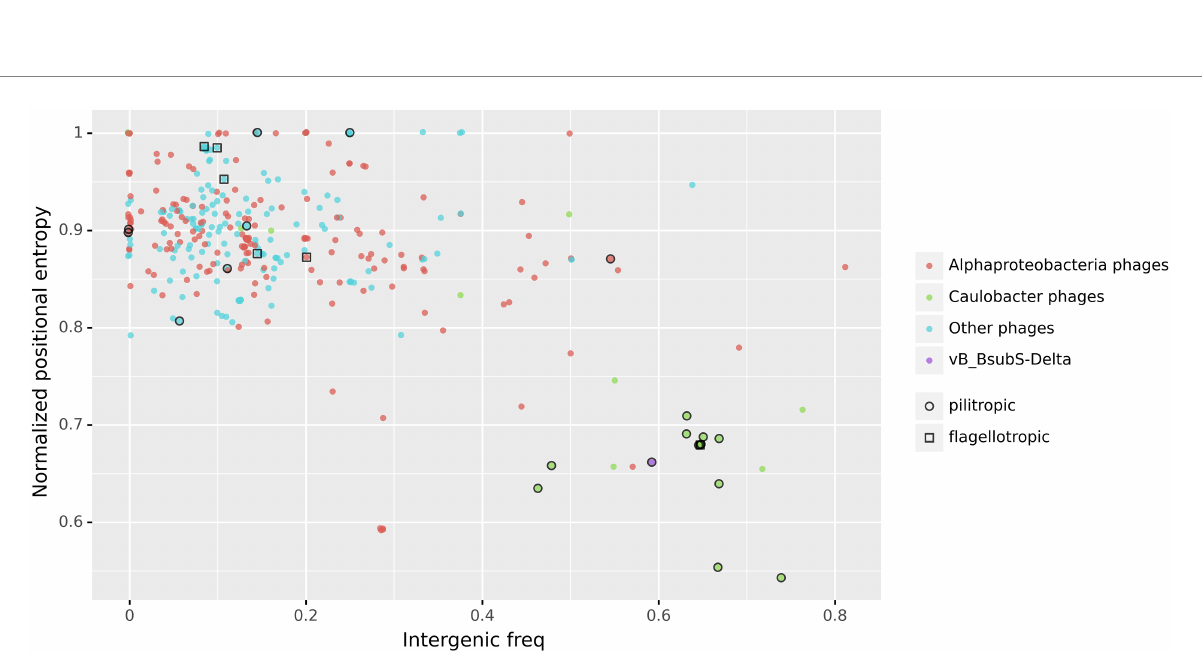
FIGURE 8 Normalized Positional Entropy vs. intergenic frequency of identified CtrA-binding sites. Each filled circle indicates the normalized positional entropy of the genome as a function of the intergenic frequency of putative CtrA-binding sites detected in its genome sequence. Uniform jitter was applied for clarity. Color coding in filled circles denotes, respectively, Caulobacter phages (green), phages infecting other Alphaproteobacteria (red), vB_BsubS-Delta phage (purple) and all the other analyzed phages (cyan). Open circles designate known pilitropic phages, and open squares denote known flagellotropic phages (Supplementary Table